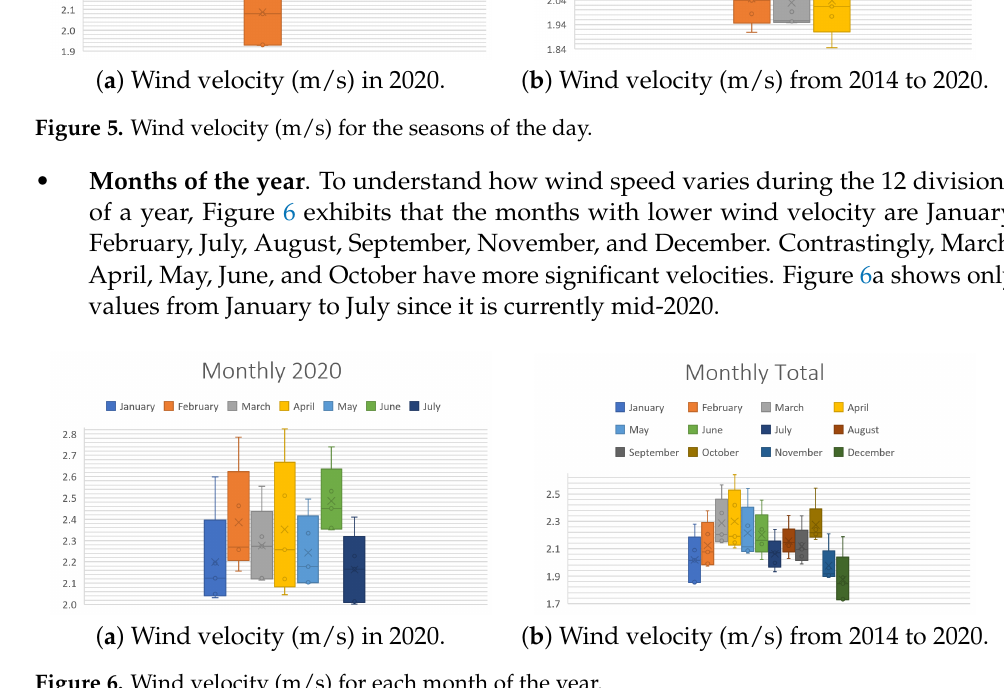
Figure 6. Wind velocity (m/s) for each month of the